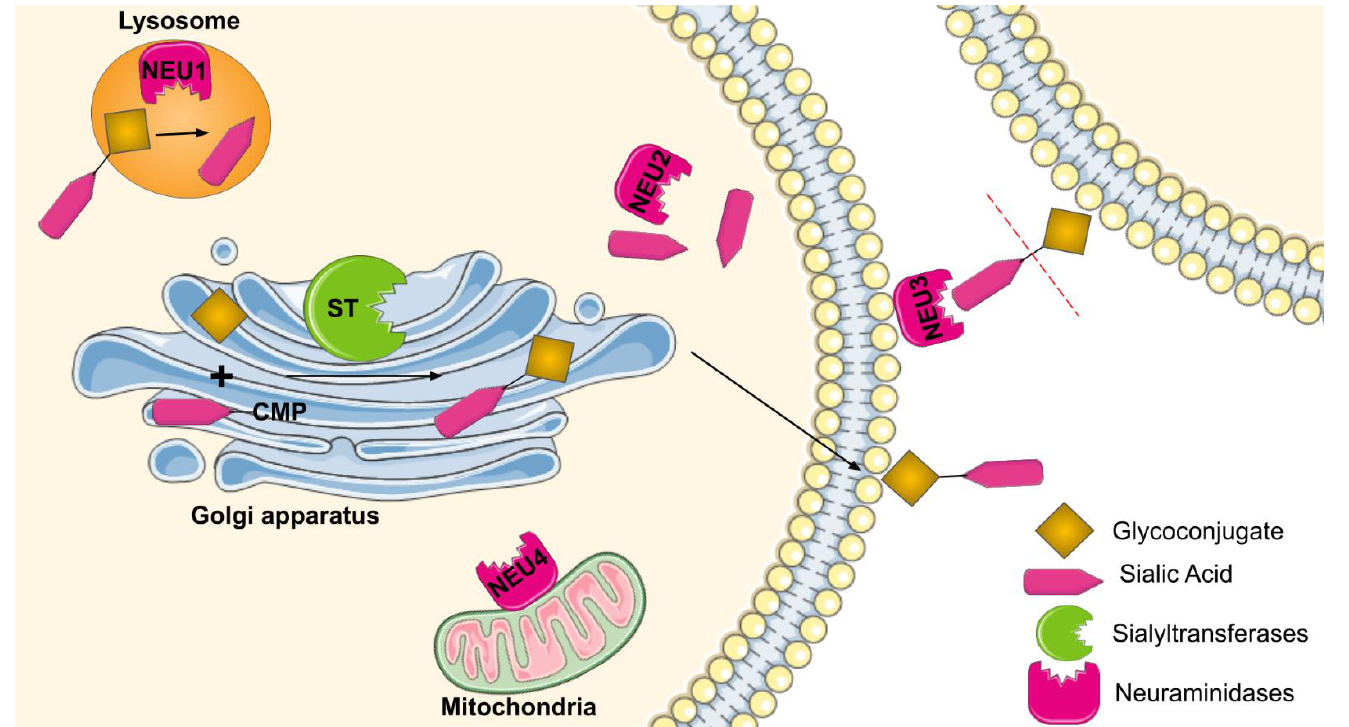
Figure 1. Sialylation and desialylation in the human cell. The diagram represents how the Golgi resident sialyltransferases attach sialic acids to the glycoconjugates, where at the same time, neuraminidases present in lysosomes, plasma membrane, and mitochondria act on the sialylated glycans and remove the sialic acids. Table 1. Human sialyltransferases (STs). Other names used to refer to them, the substrate carrier, along with the structure formed as a result of the ST activity, have been mentioned in the table below.